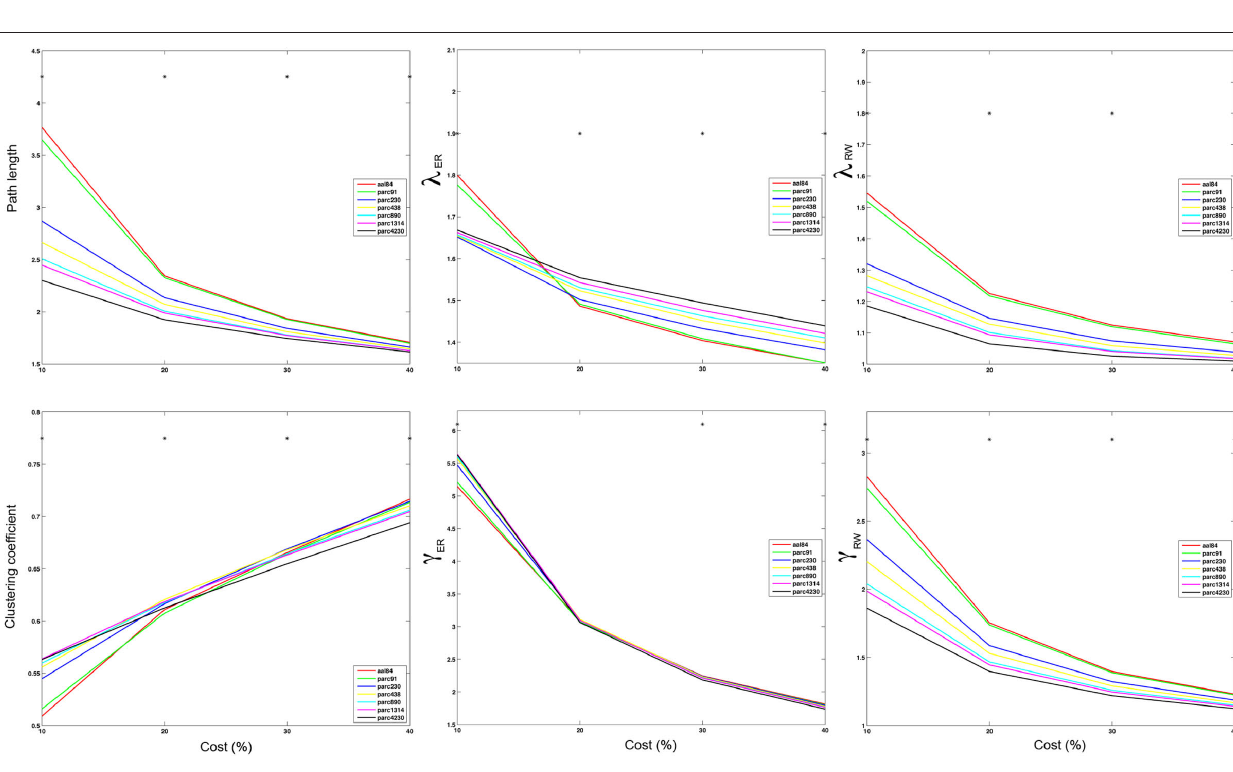
(top middle), λ (top right), clustering (bottom left), γ eR RW